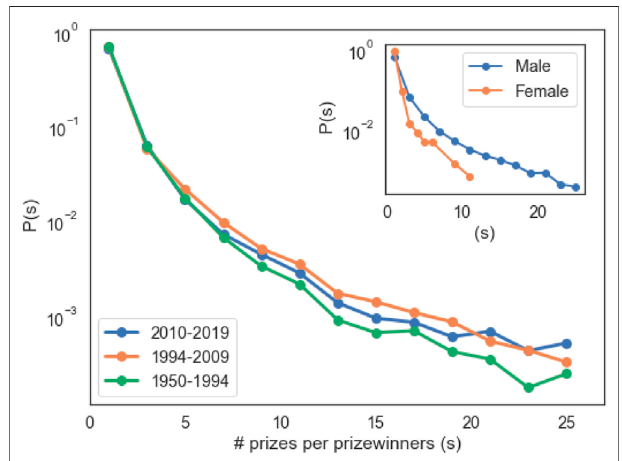
FIGURE 4 | Prize number distribution. Plots show the number of prizes per prize-winner for different periods. The three periods are separated by the trend of growth ( fl at, medium, and fast-growing periods as shown in Figure 2A ). We can see that performers are more likely to win a single prize (70%), while multiple prizewinning is slightly frequent in the recent decade. The Inset shows that the number of prizes won by the gender of performers differs a lot.